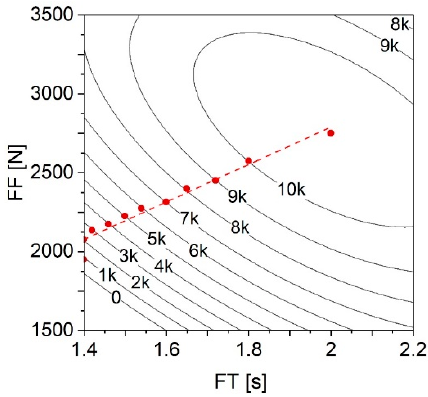
Figure 19. Contour plot for UTF (in Newton) correlated with the ranges of FT and FF. RS set at 21,000 rpm, FoT at 1.5 s, and FoF at 4500 N.